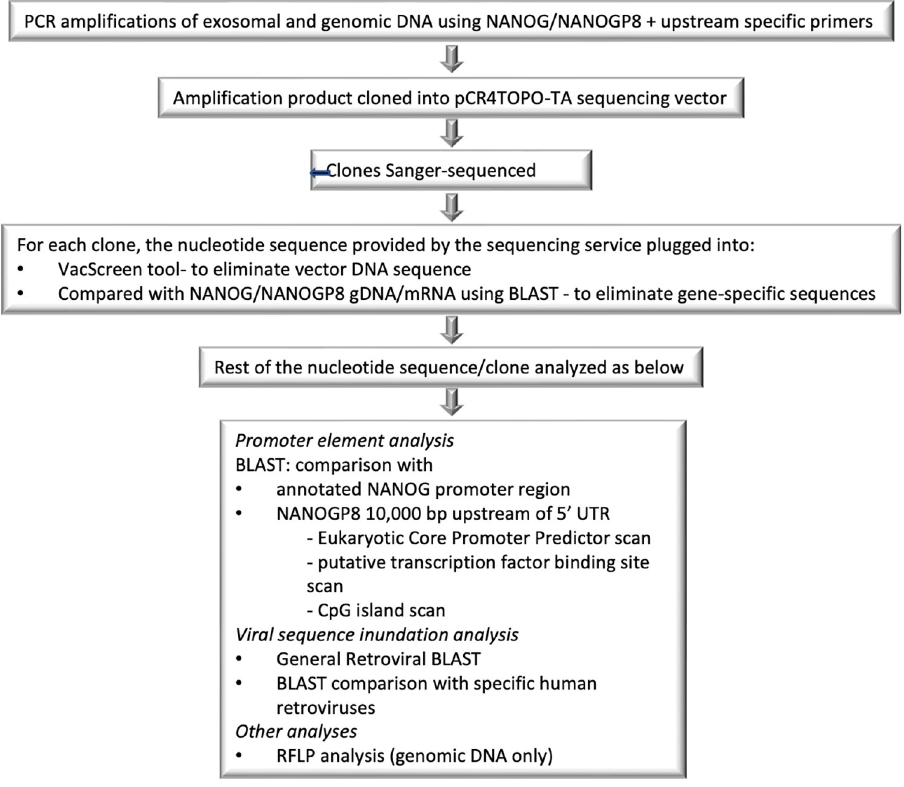
Fig 1. Schematic of the steps in exosomal and genomic DNA sequence